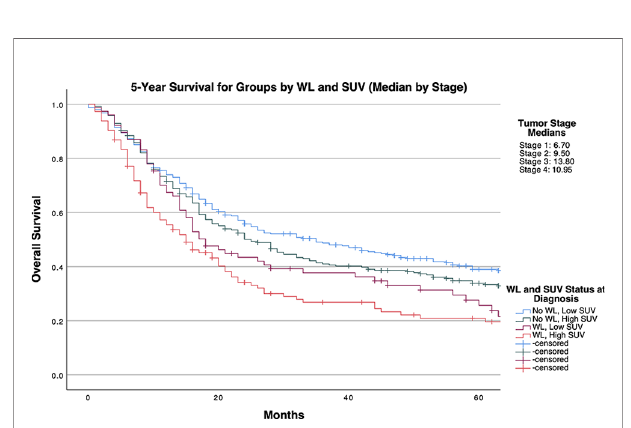
FIGURE 2 | 5-Year Overall Survival Strati fi ed by Signi fi cant Pretreatment Cancer-Associated Weight Loss (WL) and Primary Tumor SUV Max Group Determined by Cohort Median Cutpoint.